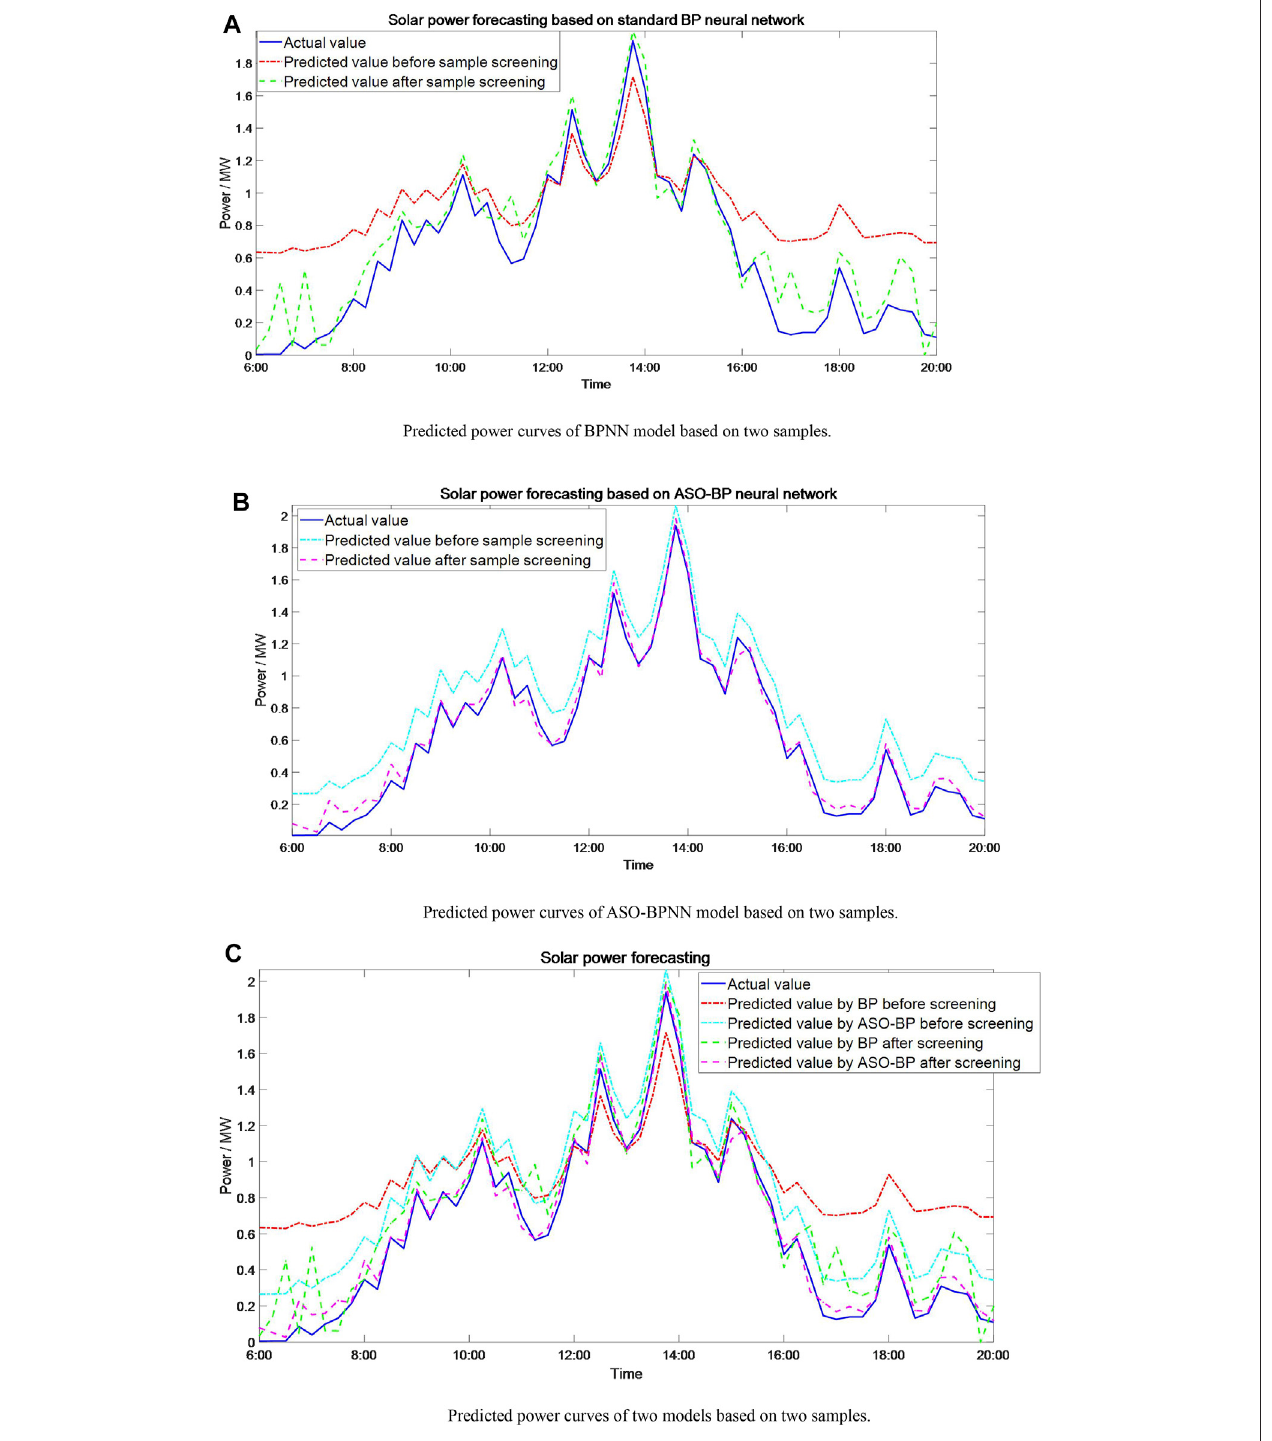
FIGURE 3 |(A) Predicted power curvesof the BPNN model based on twosamples. (B) Predicted power curves ofthe ASO-BPNN model based on two samples. (C) Predicted power curves of two models based on two samples.